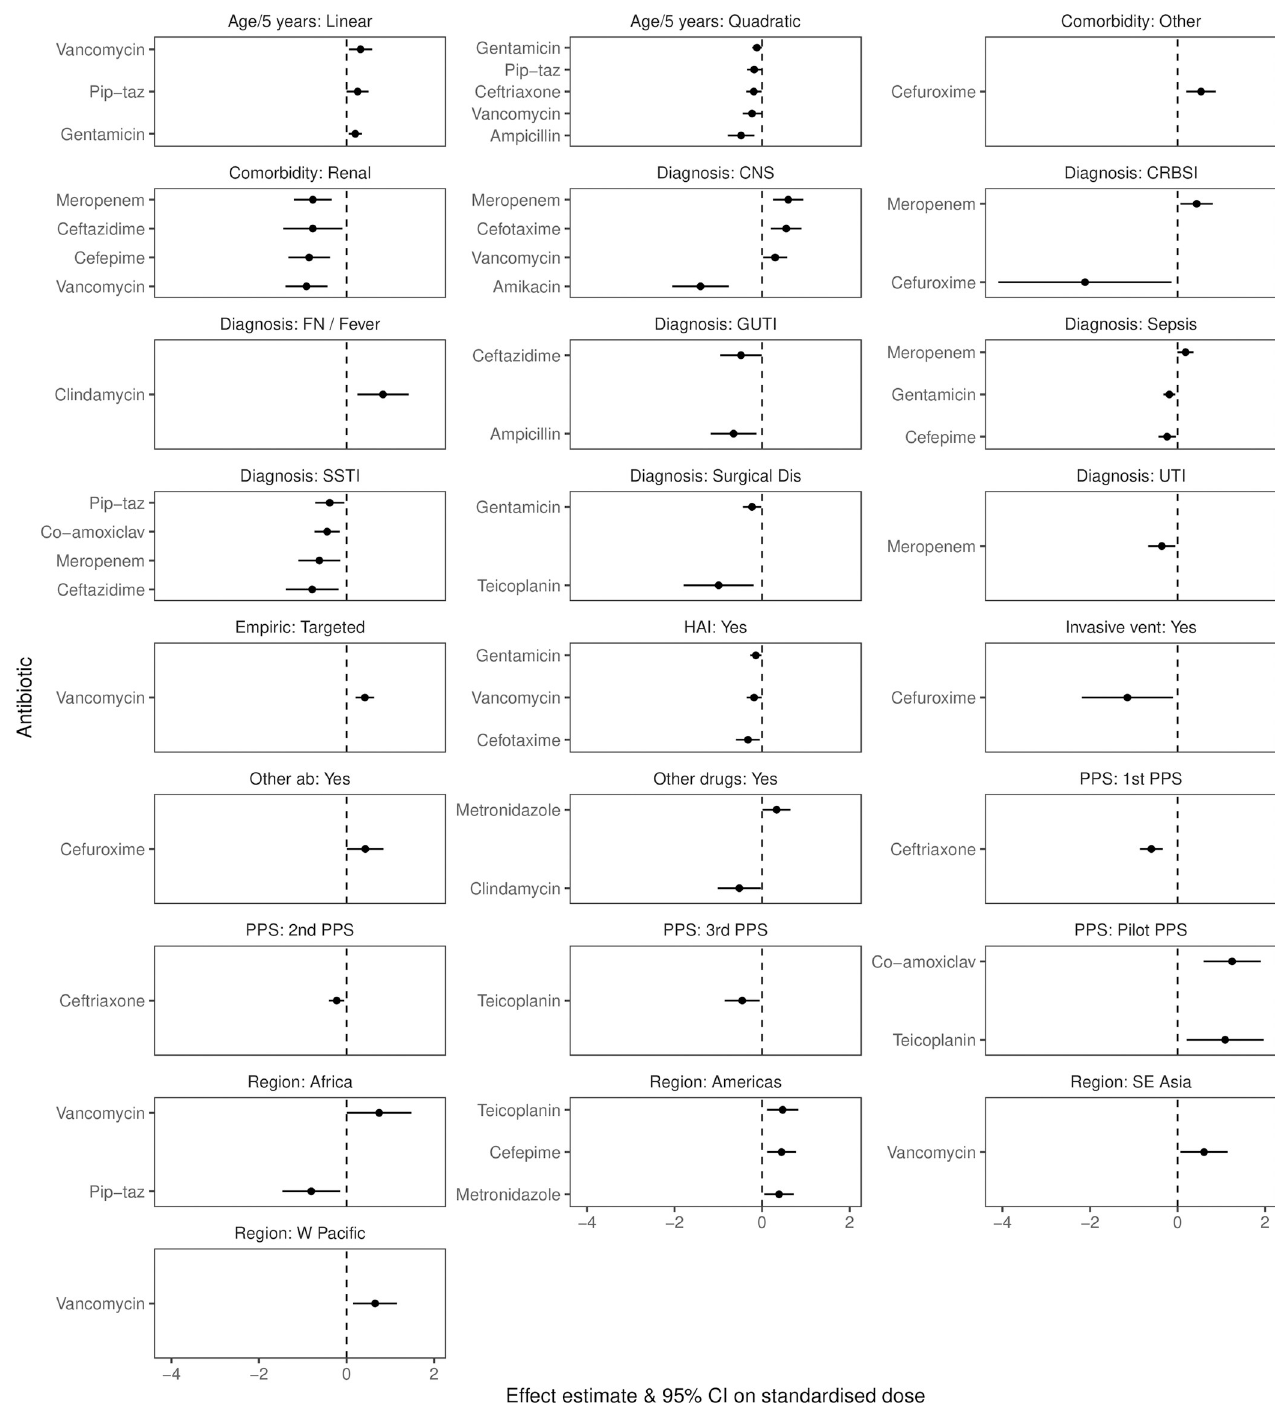
Fig 4. Effect estimates and 95% confidence intervals of significant effects (p < 0.05) from models of standardised WBD for the most common diagnoses. Models were run separately for each antibiotic and contained the same fixed and random effects for each model. Reference levels for each factor were chosen as the level with the highest proportion of doses (region: Europe, PPS: most recent survey (4th), diagnosis: bacterial LRTI, empiric: empiric, sex: male). CNS: central nervous system infection; CRBSI: catheter related blood stream infection; FN: febrile neutropenia; GUTI: gastro-intestinal tract infections; SSTI: skin and soft tissue infections; Dis: disease; UTI: urinary tract infection; HAI: hospital acquired infection; Vent: ventilation; ab: antibiotic; PPS: point prevalence survey; SE: south-east; W: west.